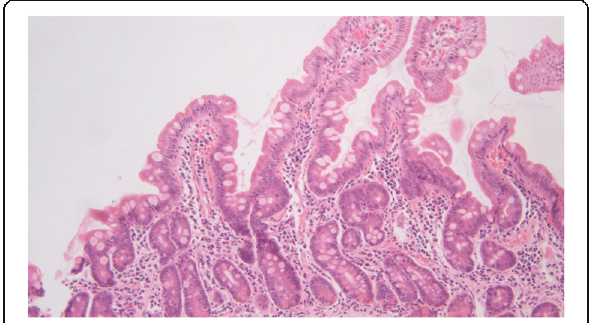
Fig. 4. The flat lesion from Figure 3 returned to a state of normalcy after 24